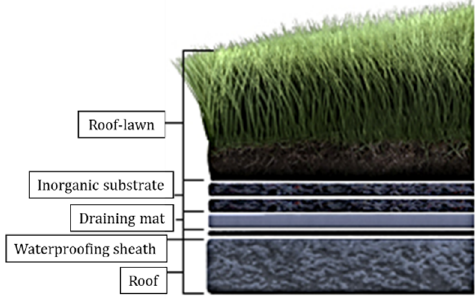
Figure 2. Green roof stratigraphy.